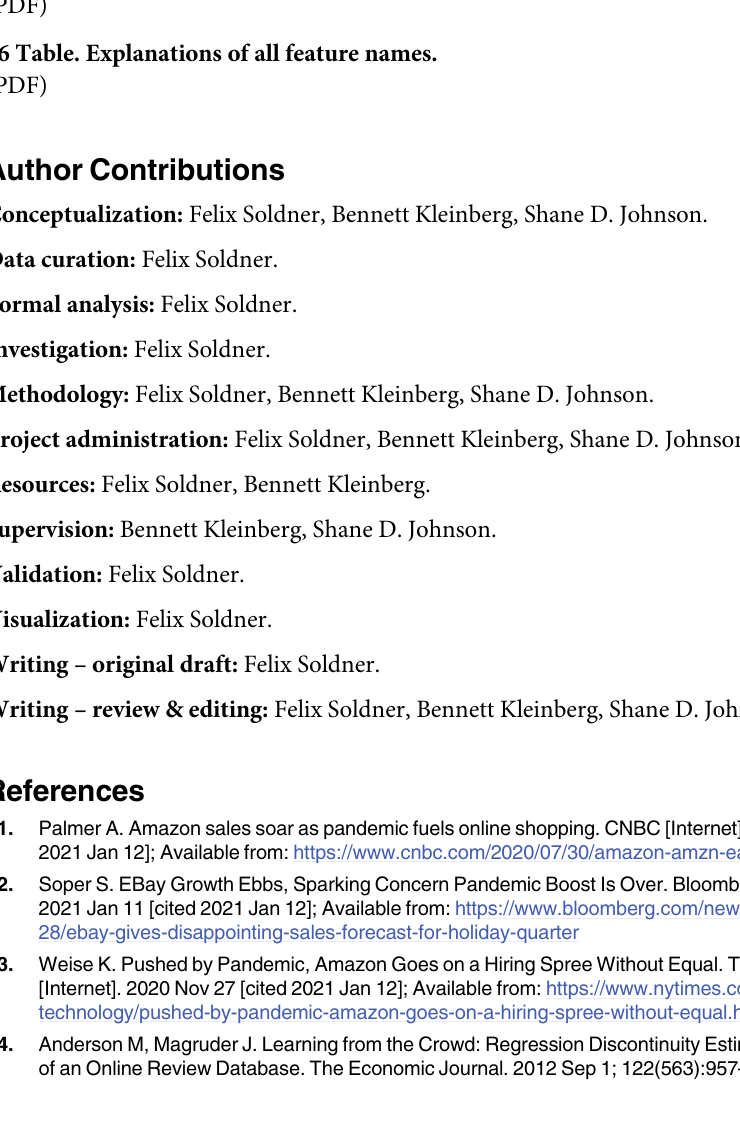
S2 Table. All features used in the classification experiments. S3 Table. Extra Trees classifier settings. S4 Table. Other tested classifiers. S5 Table. All classification performance metrics across all experiments. S6 Table. Explanations of all feature